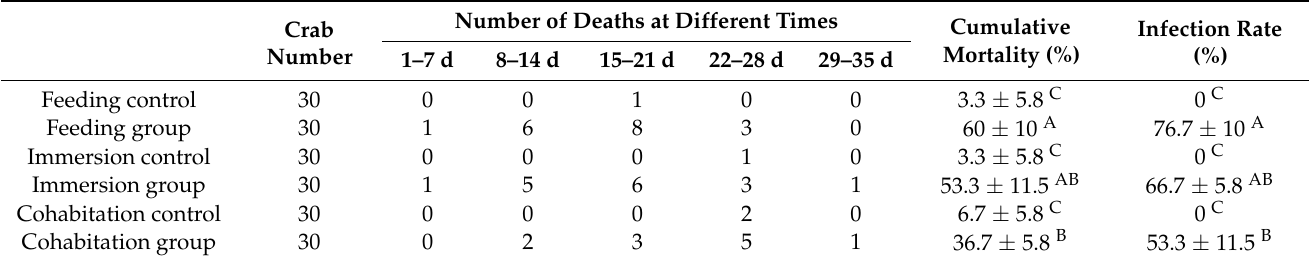
Figure 1. The Kaplan–Meier survival curves of Eriocheir sinensis challenged with Metschnikowia bicuspidata by feeding, immersion, and cohabitation. Table 1. The cumulative mortality and infection rate of different infection modes.